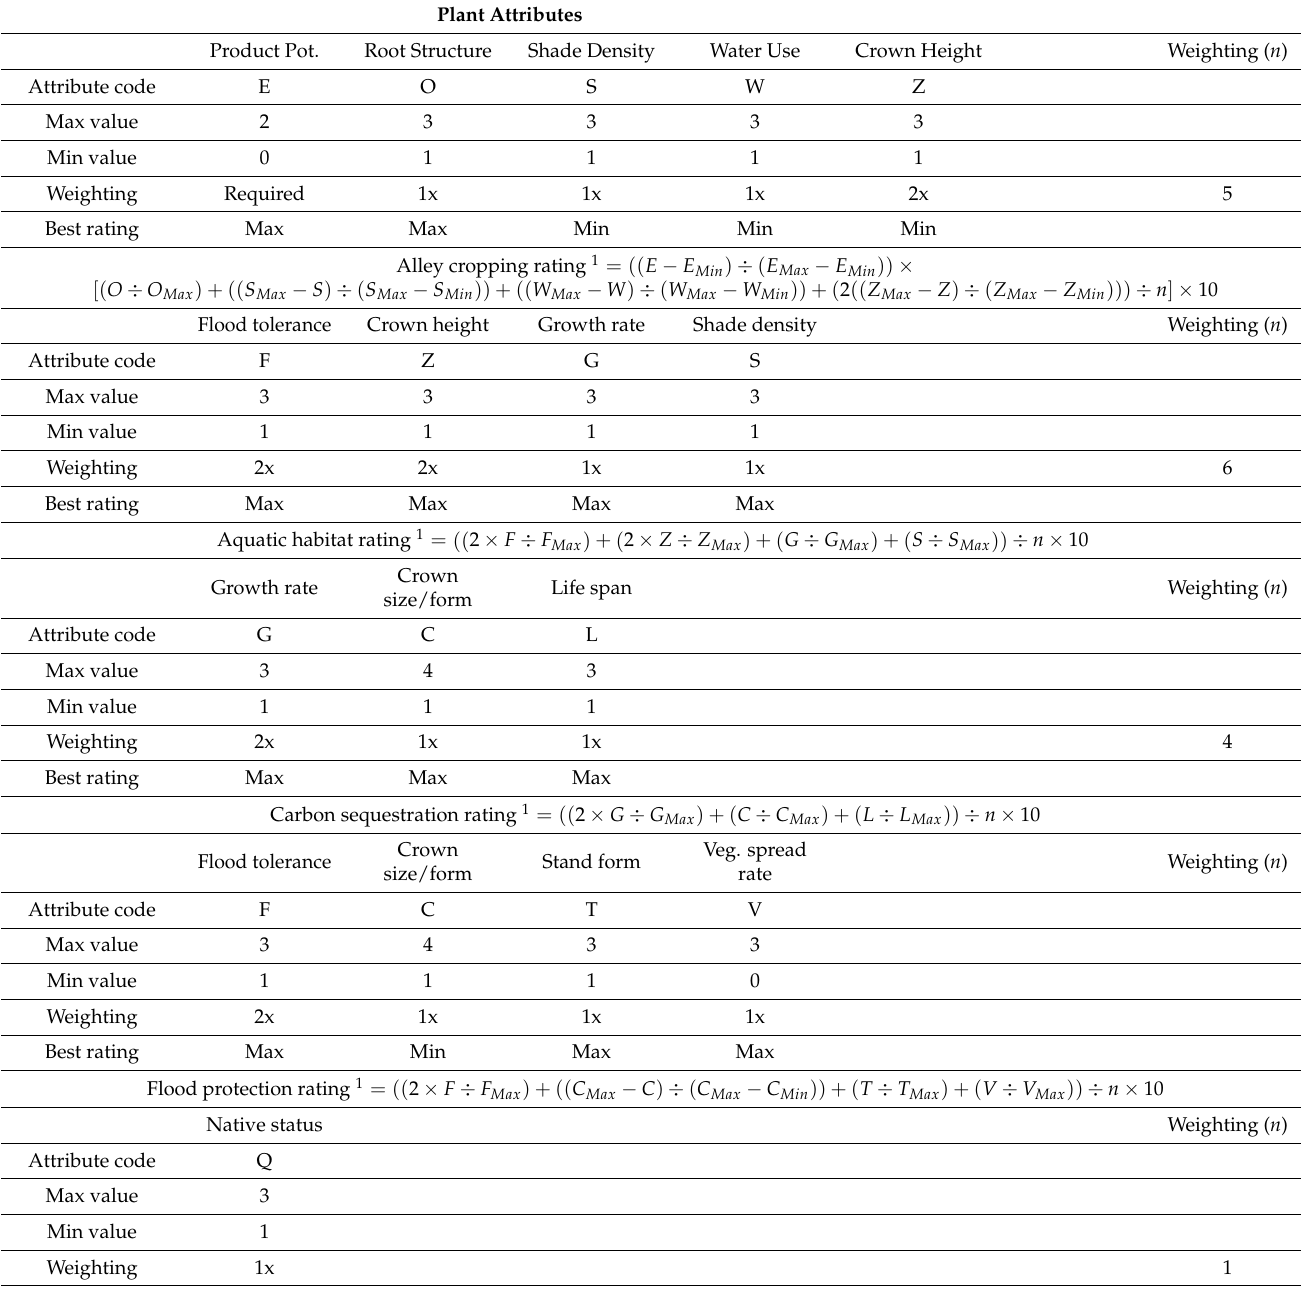
Table 3. Rating algorithms for each purpose in Tree Advisor. Plant